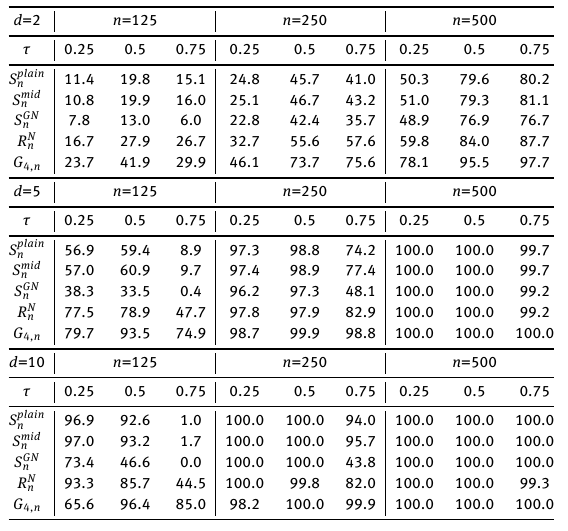
characteristic function test, with differences increasing with the number of observations and dimensions. Again S plain and S mid have the same behavior and are comparatively better than S GN n n with dependence.